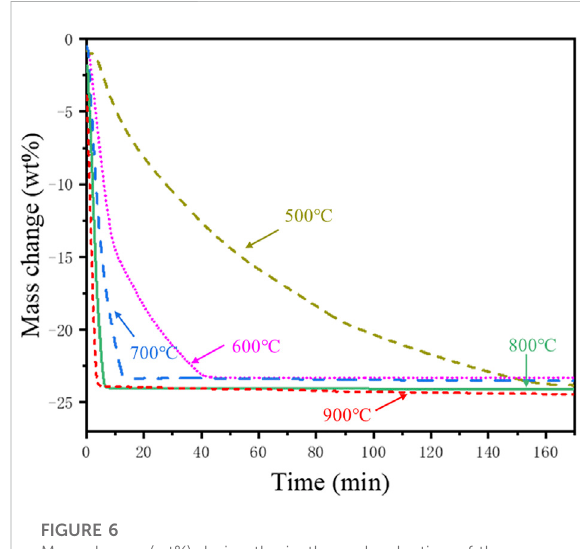
FIGURE 6 Mass change (wt%) during the isothermal reduction of the cathode